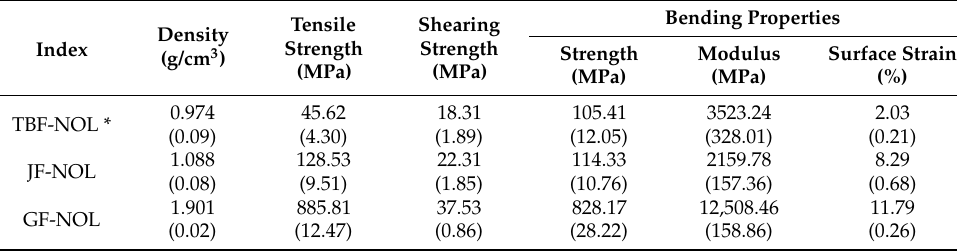
Table 1. Mechanical properties of composites made of different